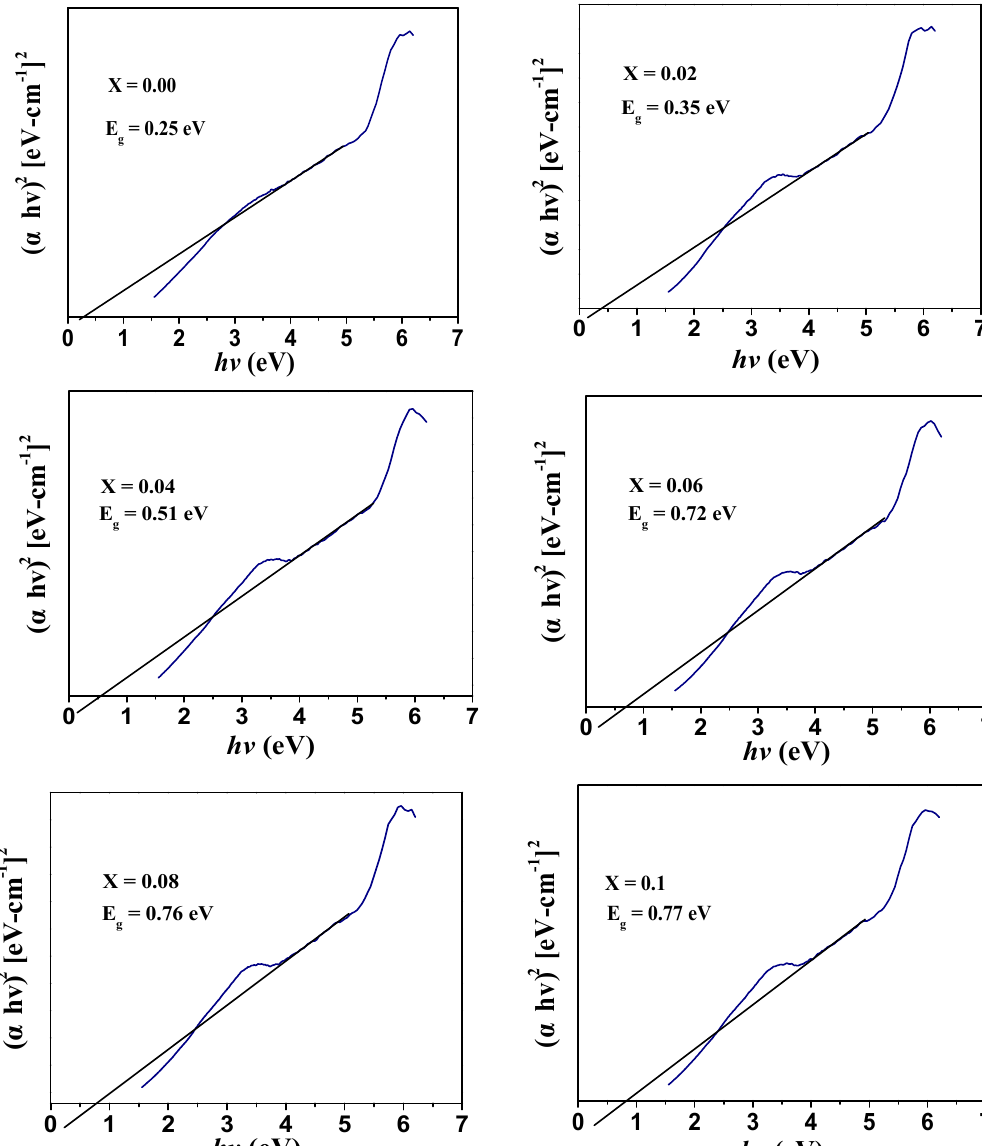
Figure 7. [ α hv] 2 versus hv graphs of the Co 0.5 Ni 0.5 Nb x Fe 2 − x O 4 (0.0 ≤ x ≤ 0.10) nanoparticles.